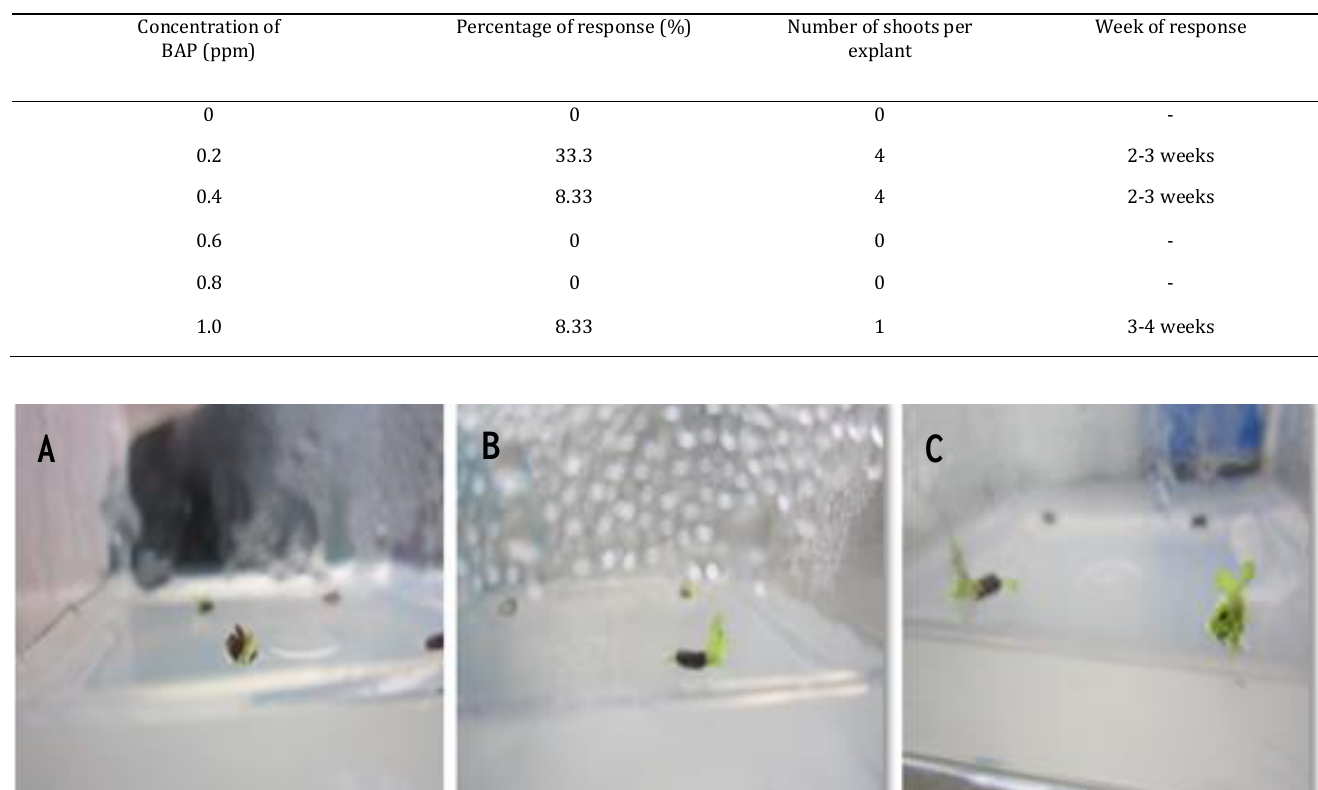
Table 1: Effects of BAP on shoot induction using axillary bud explant of O.